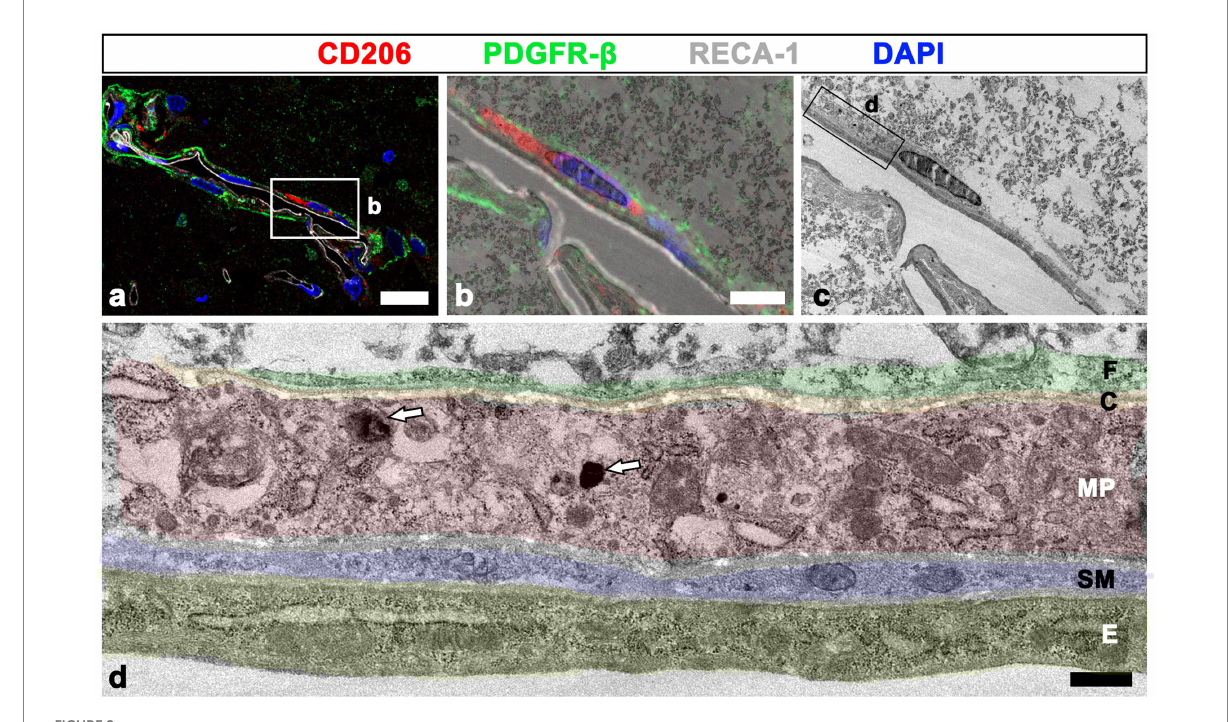
FIGURE 8 Relationship between meningeal macrophages and PDGFR- β -positive cells within penetrating vessels. (A–C) Confocal microscopic image of a semi-thin section triple labeled with CD206, PDGFR- β , and RECA-1 (A) , of a boxed area overlaid onto the corresponding electron microscopic image (B) , and the corresponding transmission electron microscopic image obtained from the same field (C) . (D) Higher magnification view of the boxed area in d showing that meningeal macrophages (MP; shaded in red) containing secondary lysosomes (white arrows in D ) are localized outside the endothelial cells ( E ; shaded in orange) and smooth muscle cells (SM; shaded in blue) and are surrounded by PDGFR- β -positive cell processes ( F ; shaded in green) and collagen fibrils ( C ; shaded in yellow). Scale bar =20 μ m for (A) ; 5 μ m for (B–C) ; 0.5 μ m for (D)